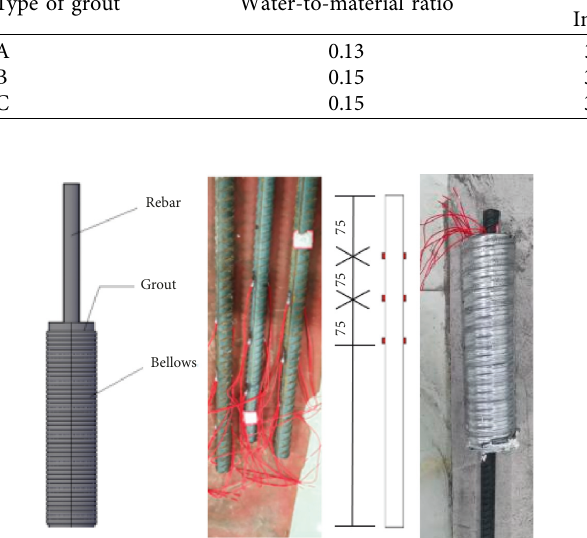
Figure 2: Specimen construction.